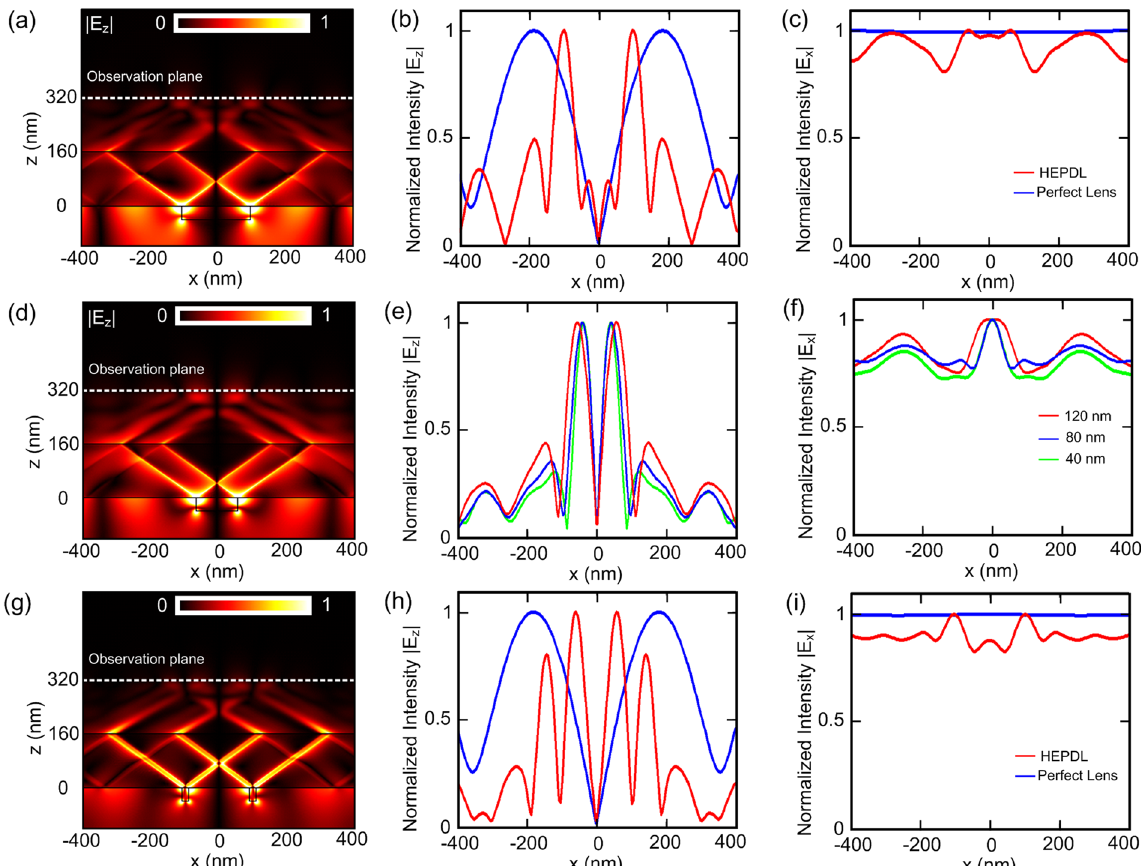
Figure 4. Detecting performance of the HPEDL in two-dimensional simulations. The simulations are performed at a nominal wavelength of λ 0 = 680 nm and the thickness of the HPEDL is 320 nm ( d 1 = 160 nm , d 2 = 160 nm ). ( a,b,c ) A PMMA strip with 200 nm width that embedded in the PC substrate. ( a ) Simulated electric-field distribution | E z | for detecting the PMMA strip with 200 nm width. ( b , c ) The line profiles of ( b ) | E z | and ( c ) | E x | at the observation plane. The case of the perfect lens is shown for comparison. ( d – f ) PMMA strips with different widths: 120 nm, 80 nm and 40 nm. ( d ) Simulated electric-field distribution | E z | for detecting PMMA strip with 120 nm width. ( e,f ) The line profiles of ( e ) | E z | and ( f ) | E x | at the observation plane. ( g , h , i ) Two PMMA strips with 20 nm width and a center-to-center separation of 200 nm. ( g ) Simulated electric-field distribution | E z | for detecting two PMMA strips with 20 nm width 20 nm and a center-to-center separation of 200 nm. ( h , i ) The line profiles of ( h ) | E z | and ( i ) | E x | at the observation plane. The case of the perfect lens is shown for